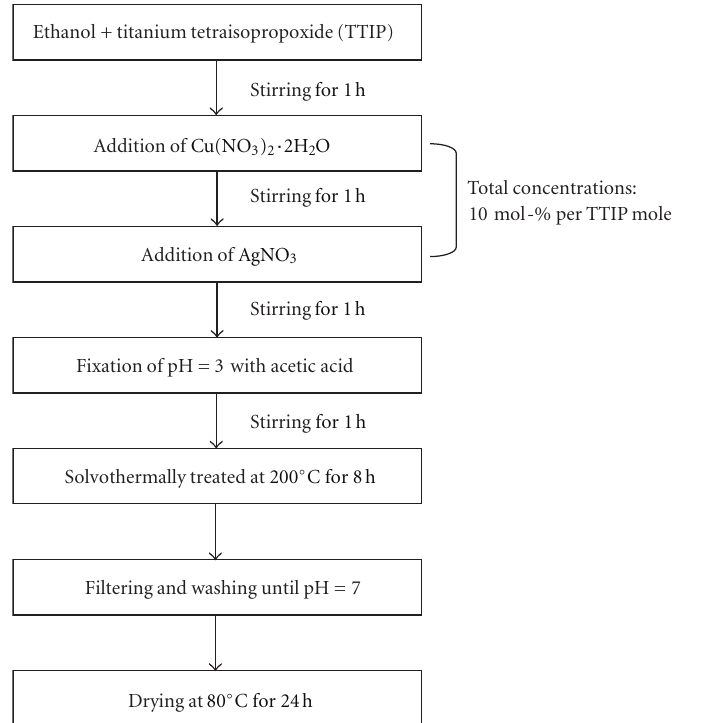
Figure 1: The preparation of six photocatalysts, pure TiO 2 , Cu(0.1)-Ti(0.9)O 2 , Ag(0.1)-Ti(0.9)O 2 , Cu(0.05)-Ag(0.05)Ti(0.9)O 2 , Cu(0.03)- Ag(0.07)Ti(0.9)O 2 , and Cu(0.07)-Ag(0.03)Ti(0.9)O 2 using a solvothermal